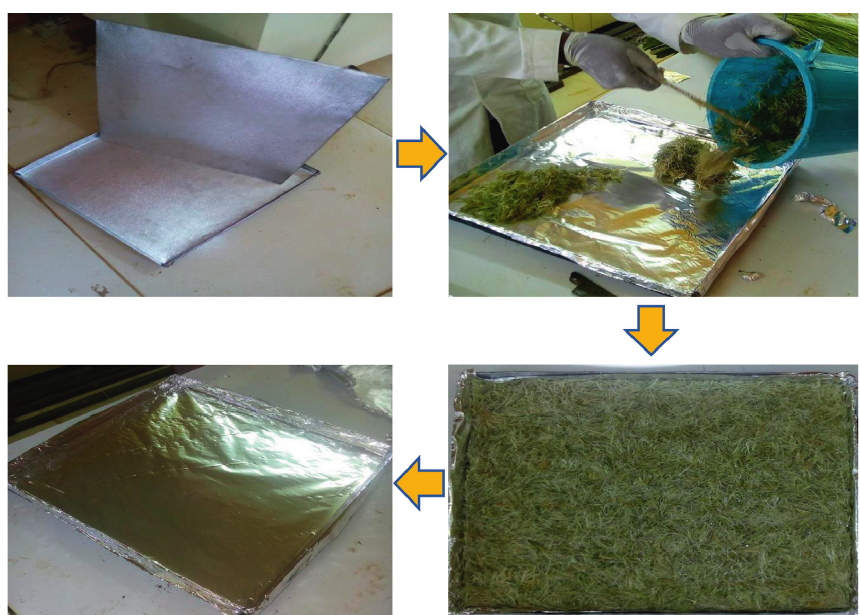
Figure 1: Fabrication of polyester hybrid composites.